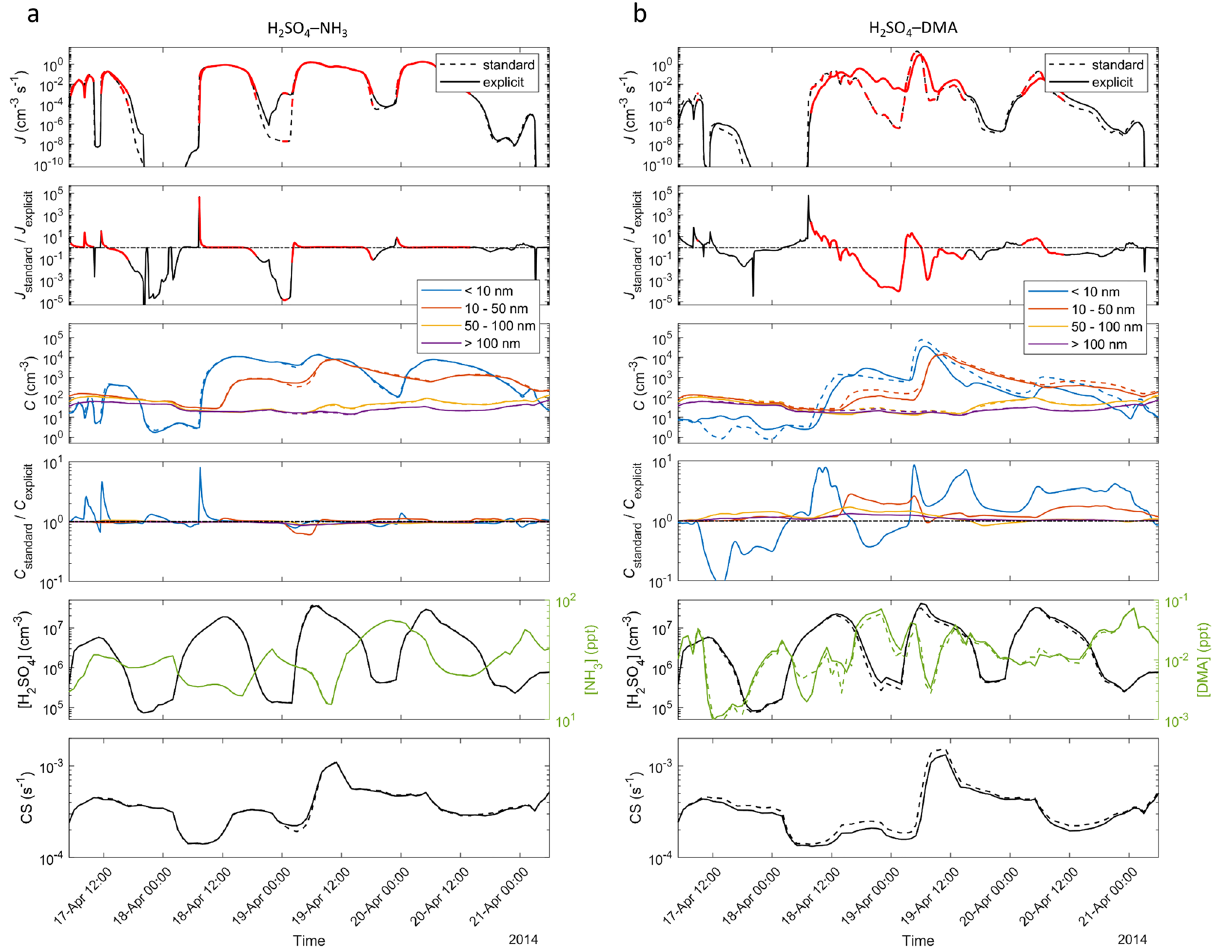
Figure 2. Particle formation rate ( J ), size-classified particle concentrations ( C ), concentrations of clustering vapors ([H 2 SO 4 ] and [NH 3 ] or [DMA]) and H 2 SO 4 condensation sink (CS) along trajectory 7 (UTC time) for the standard and explicit simulation cases with initial particle formation from H 2 SO 4 –NH 3 ( a ), and H 2 SO 4 – DMA ( b ). For J and C , also the ratio between the standard and explicit cases is shown, with the horizontal black dash-dotted line depicting a ratio of one. Periods during which J ≥ 10 −3 cm −3 s −1 for at least one of J standard and J explicit are marked with red in the time series of J . Note that both NH 3 and DMA are present in all simulations, and the difference between the H 2 SO 4 –NH 3 and H 2 SO 4 –DMA cases is only the chemical mechanism assumed for the initial particle